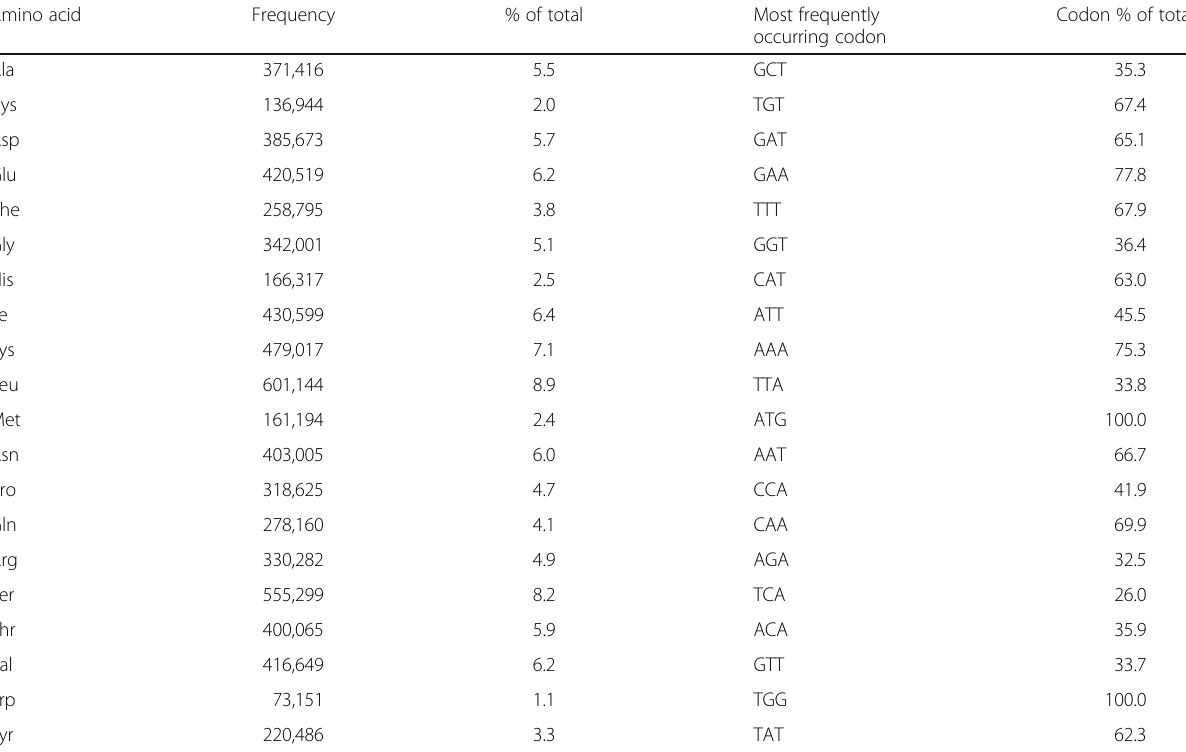
Table 5 Protein amino acid constituency and codon abundancy for Diuraphis noxia proteins Amino